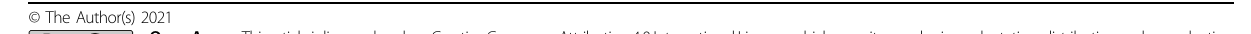
Figure 4A: the second and third panel representing results of the KKU-D131 cells have been altered to bring them more in line with other test results, though this was not declared in the article.